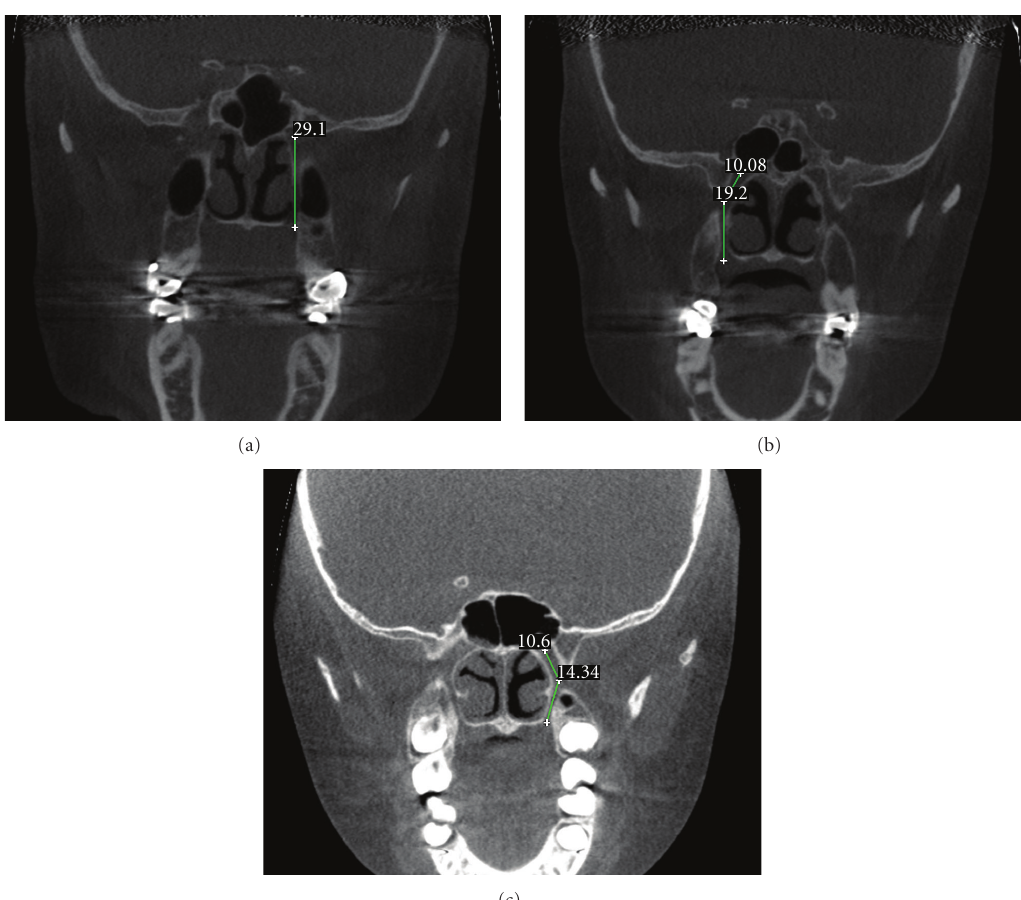
Figure 2: The coronal images above, showing unilaterally traced canals of three di ff erent subjects, were selected as examples of the most common canal pathways observed in the medial-lateral plane. The images also demonstrate how the canal paths and lengths were determined; the most straight-line path in the center of the canal, superiorly from the midpoint of the pterygoid canal entrance into the pterygopalatine fossa to the inferior surface of the horizontal hard palate. In some cases, bilateral canals could be traced in the same sagittal slice if both appeared patent (c), but in most cases only one patent canal was visible in a single slice and navigation anterior or posterior was required to see the other. Most common canal pathways demonstrated in the images are (a) canal travels directly inferior from fossa, (b) canal travels inferior-lateral for a distance then directly inferior for the remainder, and (c) canal travels inferior-lateral for a distance then inferior-medial for the